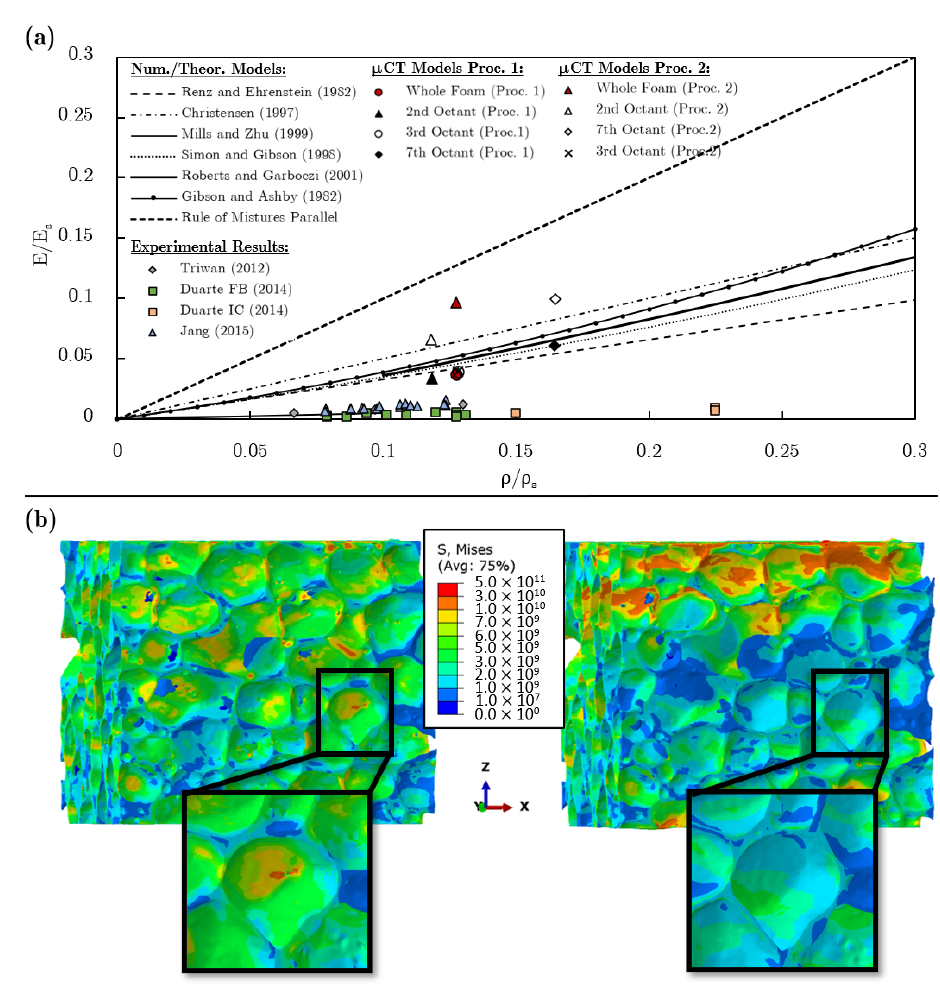
Figure 17. ( a ) Relative Young’s modulus for the closed-cell foam specimen and some of its octants prepared with Procedure 1 (defects) and Procedure 2 (no defects), numerical and theoretical models and experimental results. ( b ) Stress distribution (Equivalent von Mises) for the same specimen during a compression analysis. Procedure 1 (plain simplification) on the left and Procedure 2 (no defects) on the